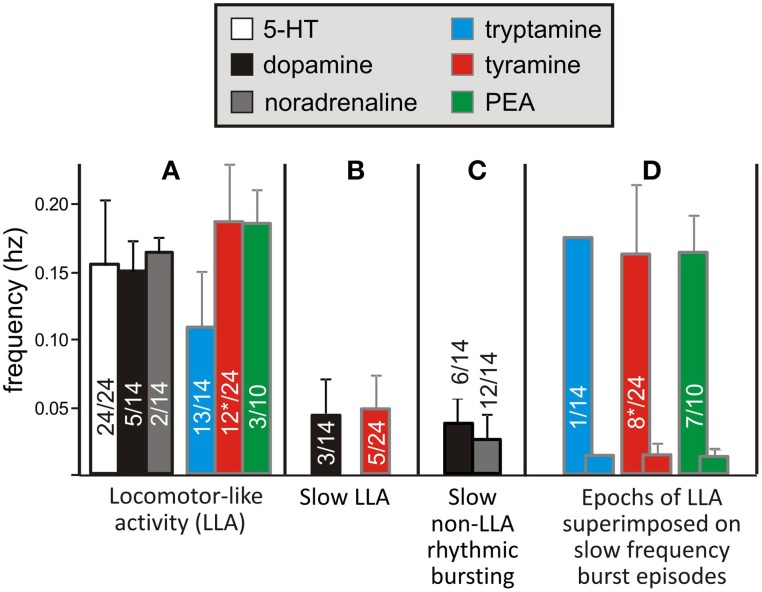
Similarities and differences in motor burst phenotypes observed with the monoamines and TAs. Four characteristic categories (A–D) describe the range bursting patterns observed. Frequencies varied depending on the type of bursting. (A) In the neonatal rat, 5-HT/NMDA-induced LLA has a characteristic frequency range, which was also seen when NMDA was co-applied with the other amines. (B) Dopamine and tyramine also produced a much slower rhythm, but with the same flexor-extensor left-right locomotor-like coordination. (C) NA and tyramine could also produce a much slower rhythm, but without locomotor-like coordination. (D) Seen only with the TAs, this episodic pattern is described as “Bouts of LLA superimposed on slow frequency burst episodes.” LLA and the slower episodic bursts are represented as overlapping bars in this grouping. The frequencies of slow LLA (B), slow non-LLA rhythmic bursting (C), and the slow frequency of episodic bursting (D) were statistically slower than LLA. Asterisks (*) denote inclusion of an animal for tyramine in two categories as both behaviors emerged at different times.